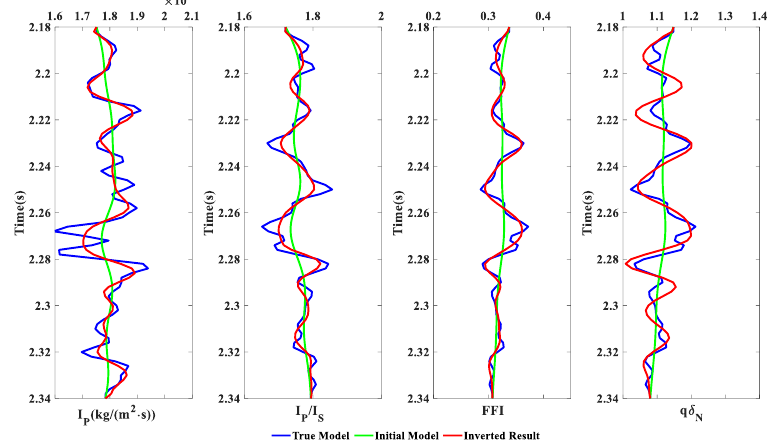
Figure 6. The inverted results of model parameters with SNR = 2.